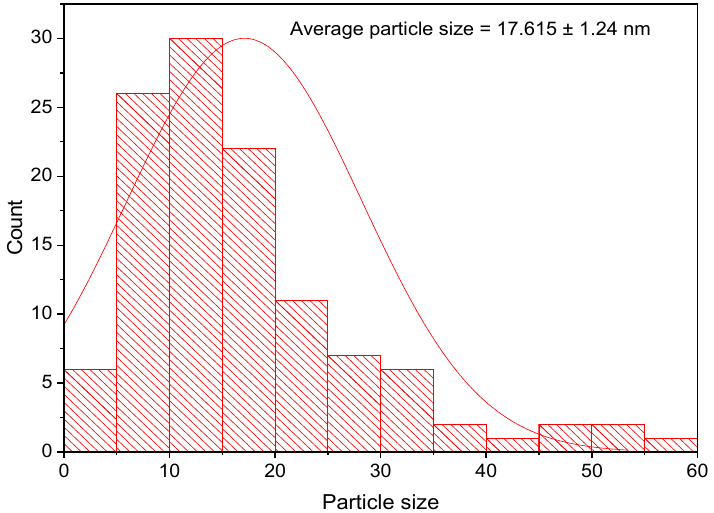
Figure 5. Particle size distribution histogram of the biosynthesized silver nanomaterials (number of analyzed particles =